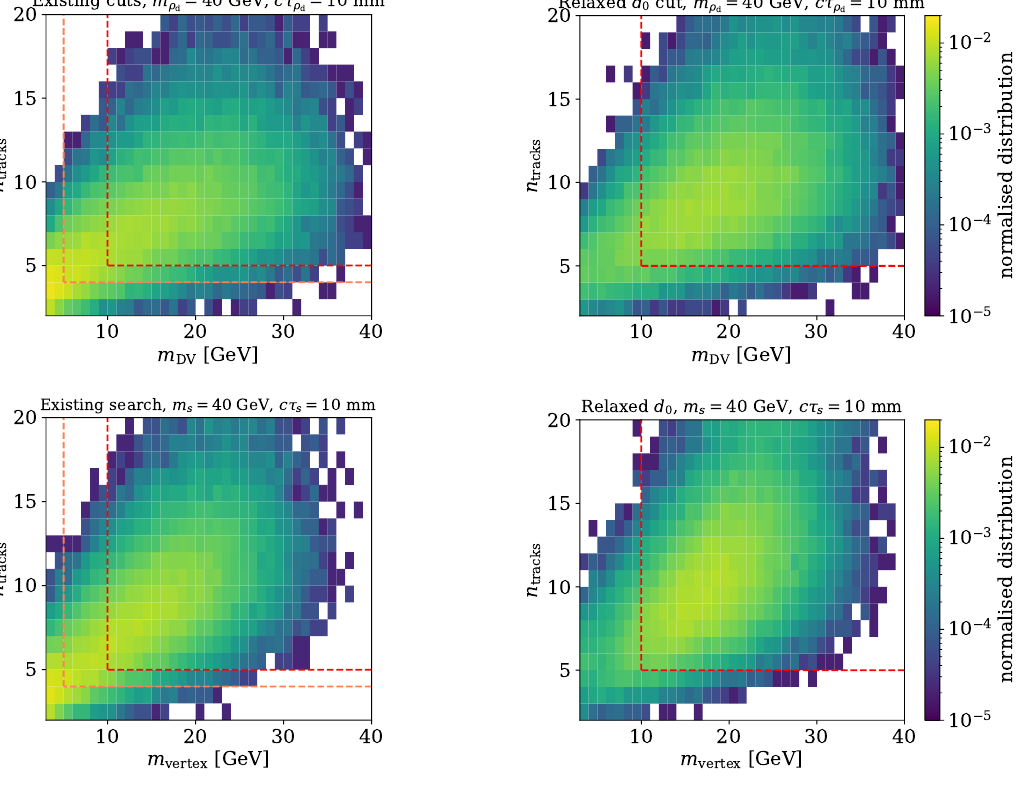
Figure 5 . Distribution of vertex mass and number of tracks per displaced vertex originating from dark ρ 0 mesons (top) and dark Higgs bosons (bottom) after the track-level cuts of the existing d analysis (left) and of the ‘relaxed d modification (right). The search window is shown with dashed 0 ’ lines. On the left, we additionally show the search window of the ‘relaxed cuts’